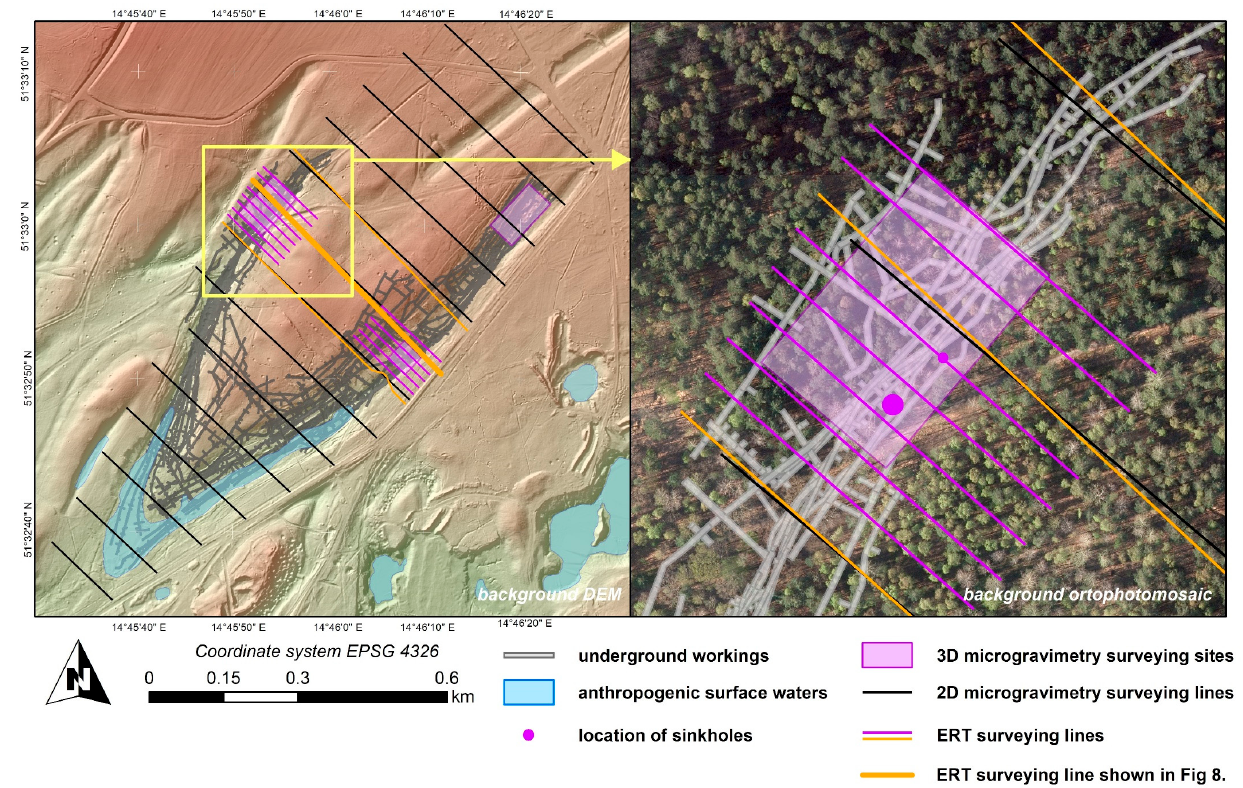
Figure 5. Location of geophysical surveys in relation to topography and documented underground workings in test field three.